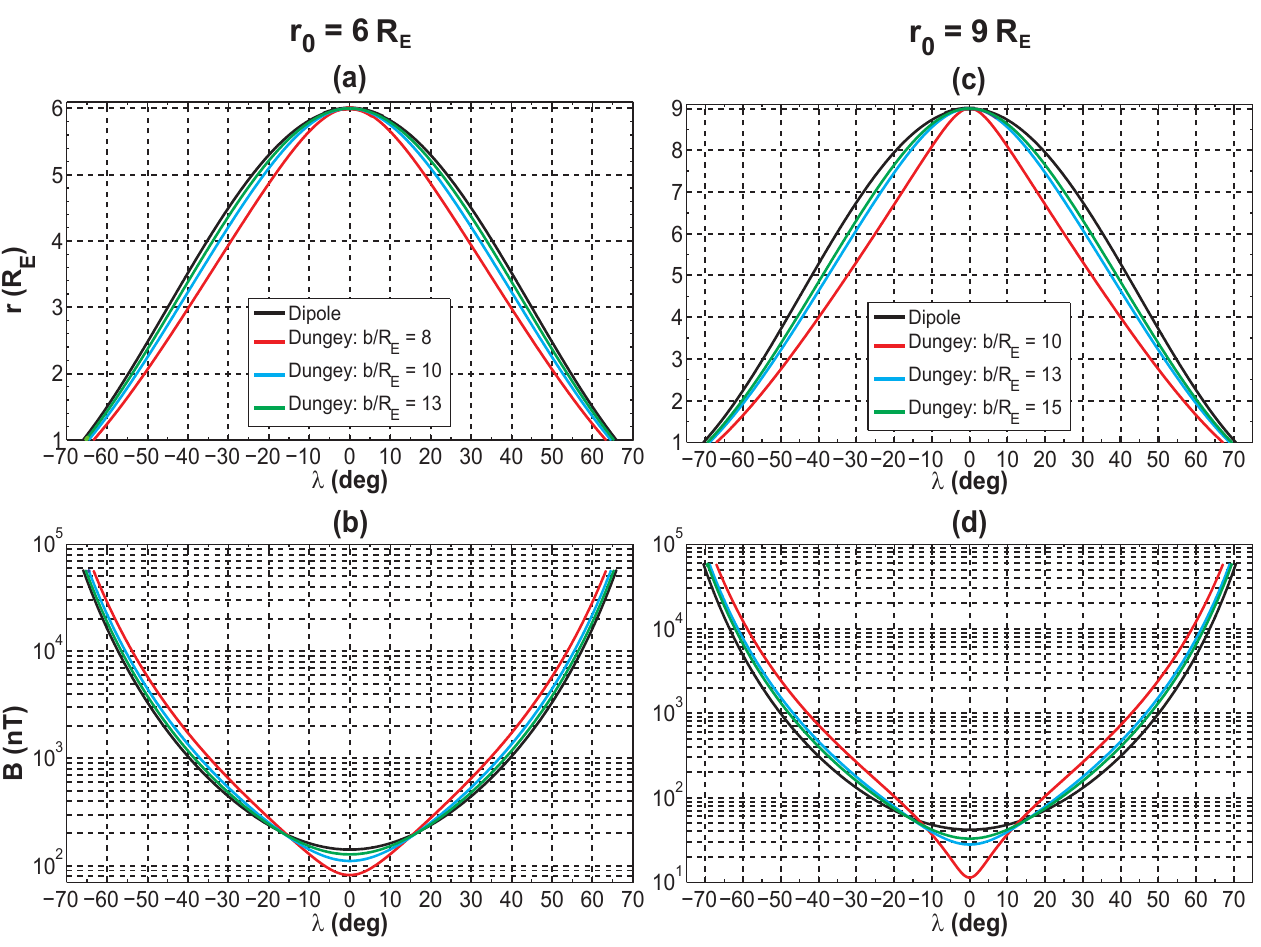
Fig. 1. Field line configuration and magnetic field intensity of the Dungey magnetosphere for the field lines with two specific equatorial crossings of (a) , (b) r 0 = 6 R E for b / R E = ∞ (dipole), 13, 10, and 8, and of (c) , (d) r 0 = 9 R E for b / R E = ∞ (dipole), 15, 13, and